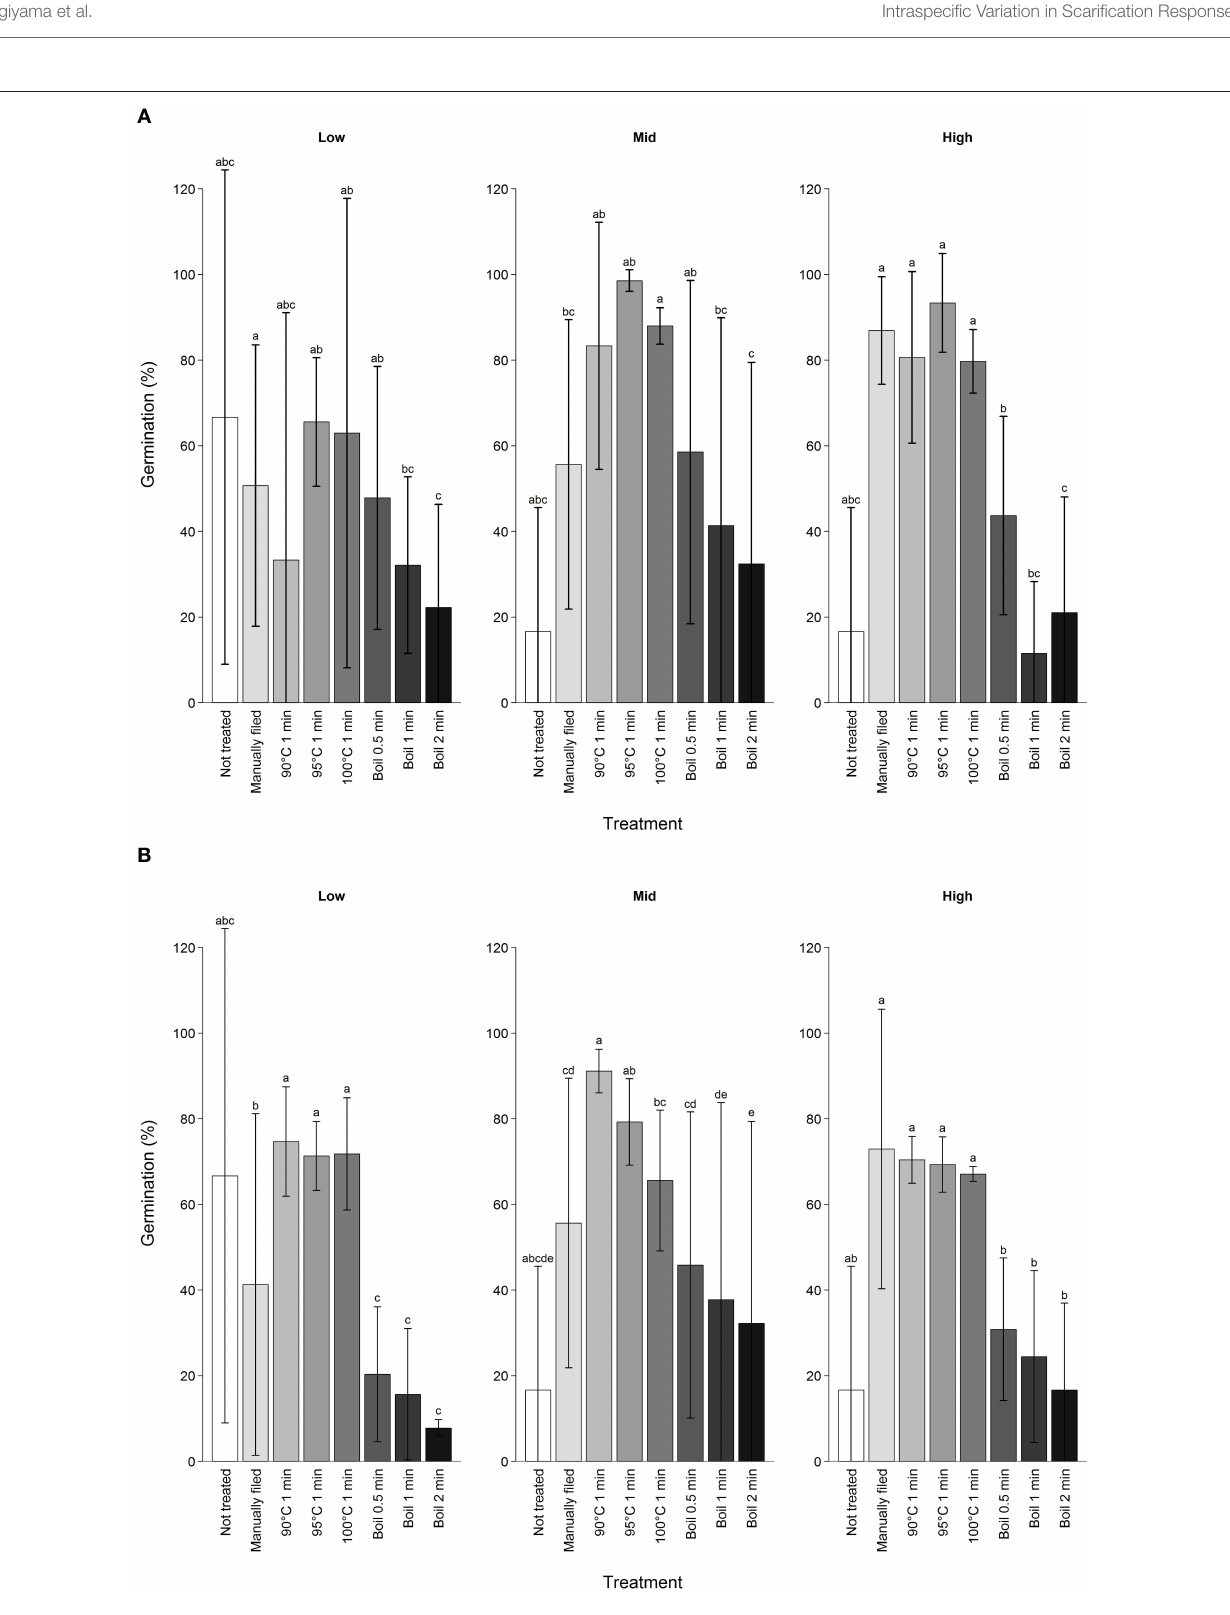
Frontiers in Plant Science |